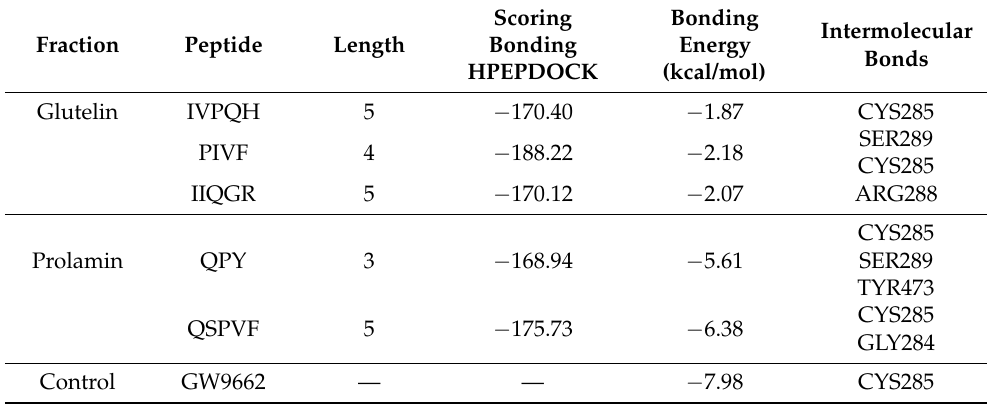
Table 3. Bonding energies and intermolecular bonds in antiadipogenic sites of PPAR γ .